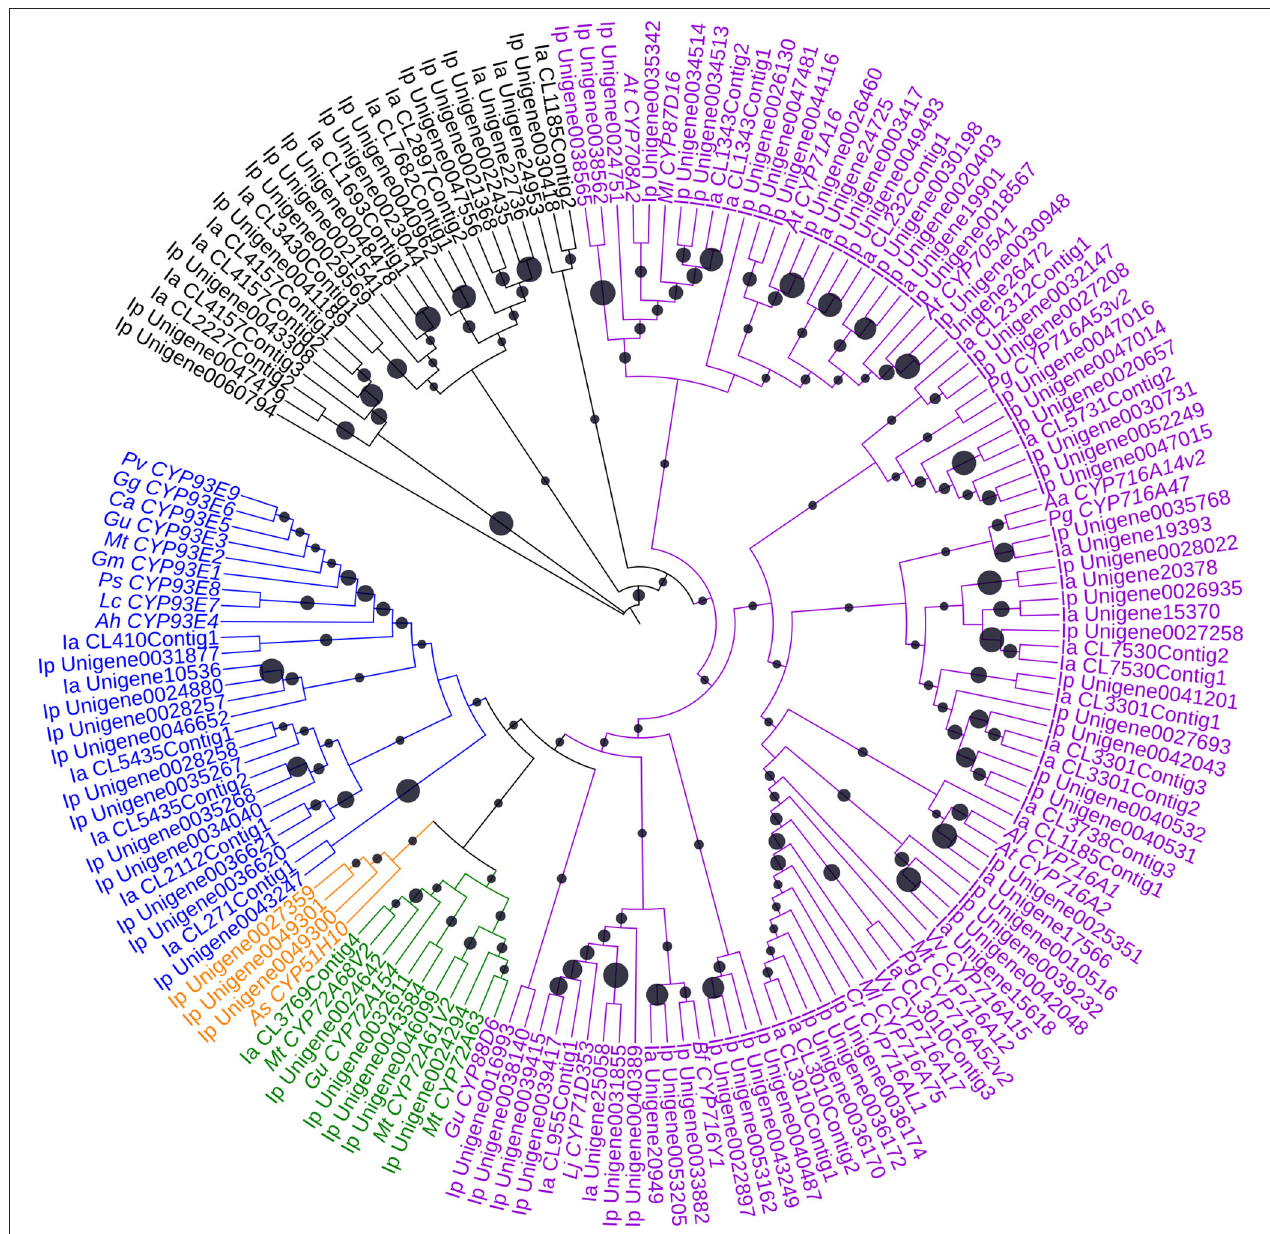
FIGURE 3 | Phylogenetic analysis of CYPs. The statistical methods of this unrooted tree was the same as Figure 2 . The blue, orange, green, purple and black indicate the indicate the cytochrome P450 clustered together with the CYP71, CYP51, CYP72, CYP85 and other clans, respectively. Black circle size means the bootstrap percentage of total number test. Aa, Artemisia annua ; Ah, Arachis hypogaea ; Al, Arabidopsislyrata subsp. lyrata ; As, Avena strigosa ; At, Arabidopsis thaliana ; Bf, Bupleurumfalcatum ; Ca, Cicer arietinum ; Cr, Catharanthus roseus ; Gg, Glycyrrhiza glabra ; Gm, Glycine max ; Gu, Glycyrrhiza uralensis ; Ia, Ilex asprella ;